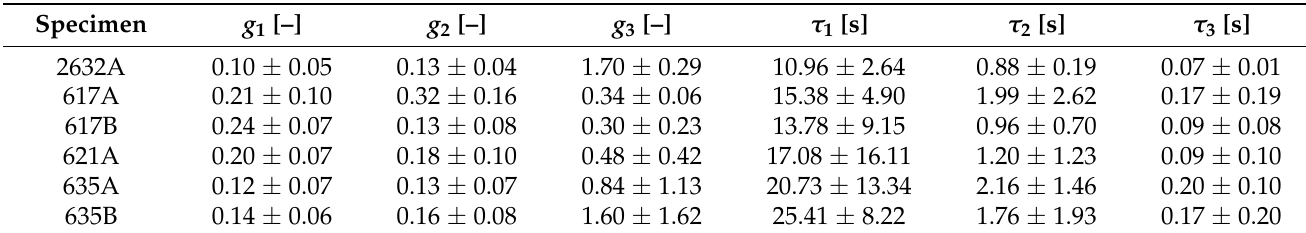
Table 2. Average ± standard deviation of the parameters g 1 , g 2 , g 3 and τ 1 , τ 2 , τ 3 of the viscoelastic model in the four relaxation stages obtained for each specimen.